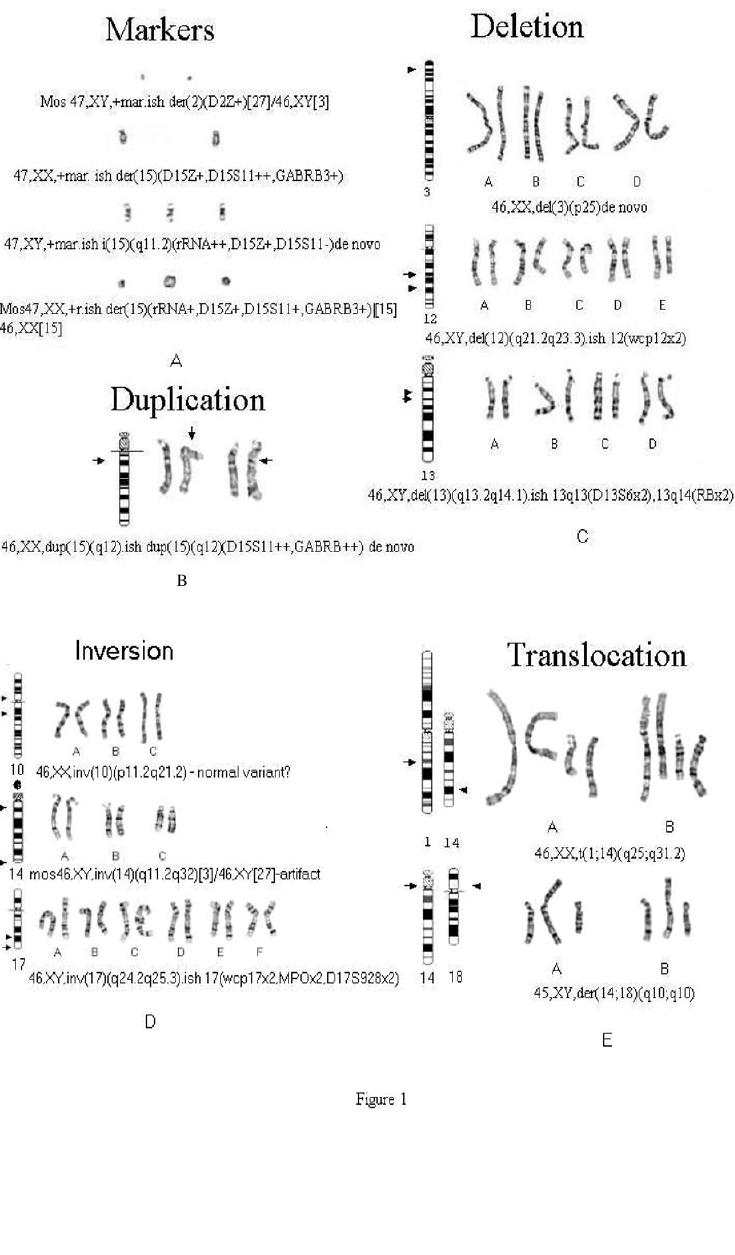
Figure 1 Chromosome abnormalities in patients with autistic traits (A) 4 markers: [multiple copies] derived from chromosome 2 [1], 15 [3] with nomenclature (B) 1 duplication of chromosome 15 with arrow denoting the region involved (C) 3 partial deletions (right homolog)(multiple copies) of 3p25, 12q21.2q23.3 & 13q13.2q14.1 with the ideogram, the arrows denote the deleted region. (D) 3 inversions (the right homolog) (multiple copies), inv(10)(p11.2q21.2), inv(14)(q11.2q32), inv(17)(q24.2q25.3) with arrows on the ideogram showing the inverted region (E) 2 translocations (partials in 2 copies, chromosomes involved (right) and their normal homolog (left)) one apparently balanced t(1;14)(q25;q31.2) and one unbalanced der(14;18)(q10;q10). The ide- ogram with arrows show the